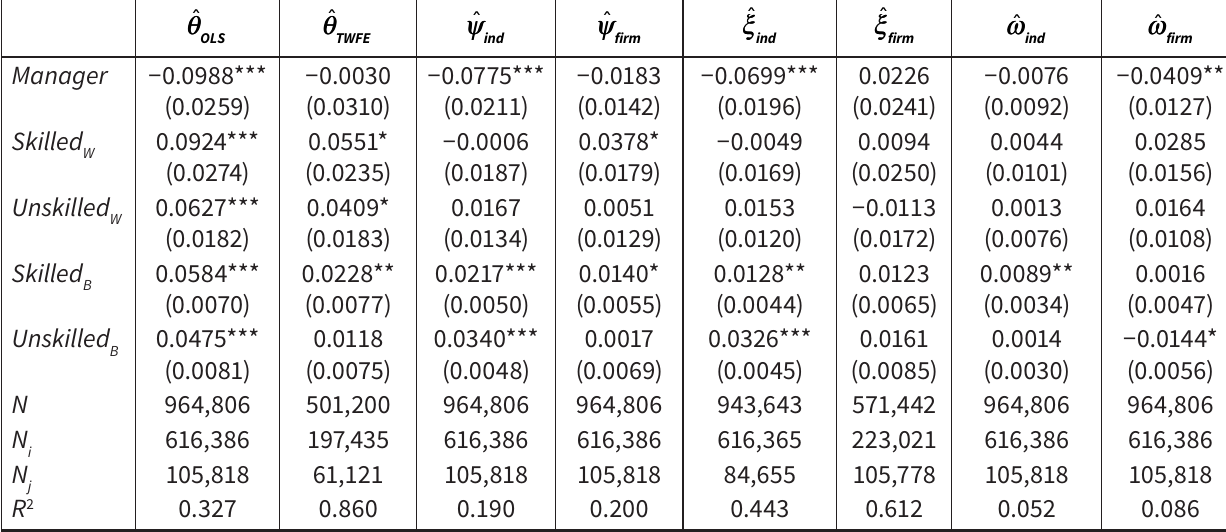
Decomposition of co-worker gains by occupations—male